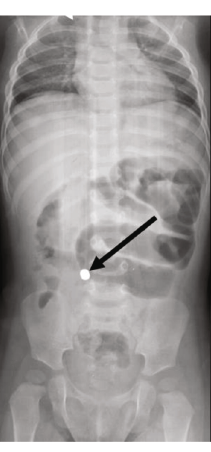
Figure 1: Dilated bowel loops with a radioopaque foreign body (indicated with an arrow).